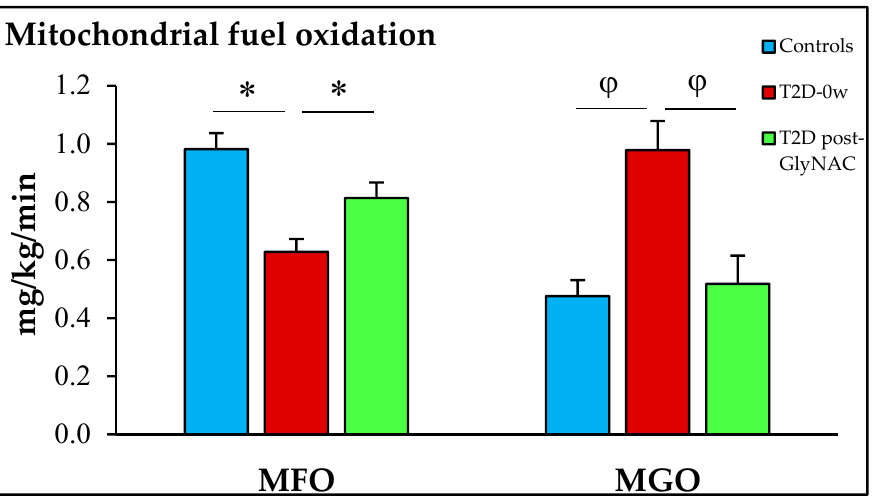
Figure 1. GlyNAC supplementation improves impaired mitochondrial fuel oxidation in patients with T2D. T2D = type 2 diabetes; MFO = mitochondrial fatty-acid oxidation; MGO = mitochondrial glucose oxidation; T2D-0w = T2D patients before GlyNAC supplementation; T2D post-GlyNAC = T2D patients 2-weeks after GlyNAC supplementation. ∗ = p < 0.001; ϕ = p < 0.01. Fasting participants with T2D had 103%, 160% and 76% higher concentrations of plasma glucose ( p < 0.0001), insulin ( p = 0.0002) and FFA ( p = 0.015) respectively, and 425% higher insulin resistance ( p = 0.0002) compared to non-diabetic controls. GlyNAC